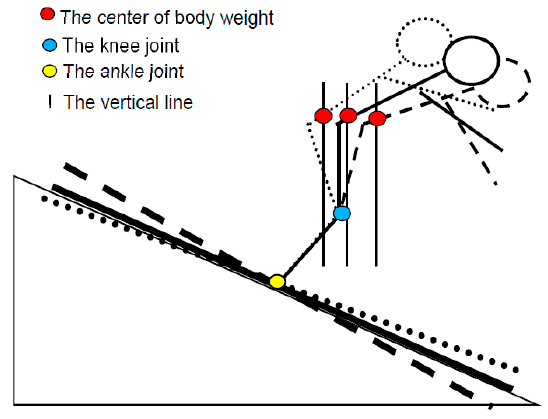
Figure 5. Overlay effect. Figure 5. Overlay e ff